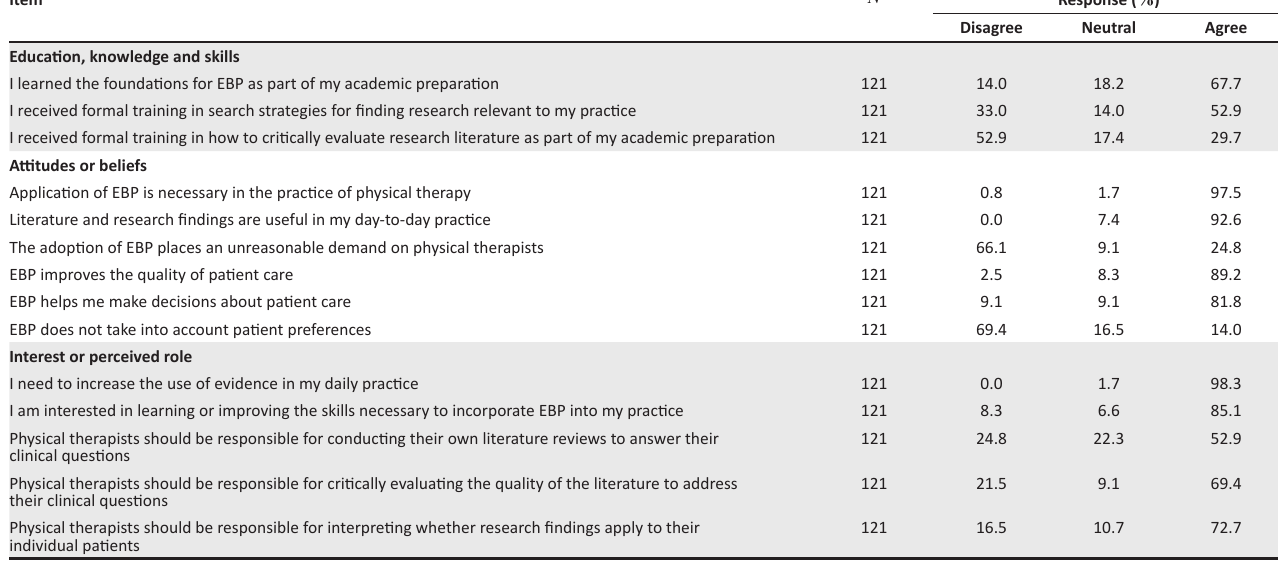
TABLE 3: Education, attitudes and beliefs, and interest and perceived role in evidence-based practice.